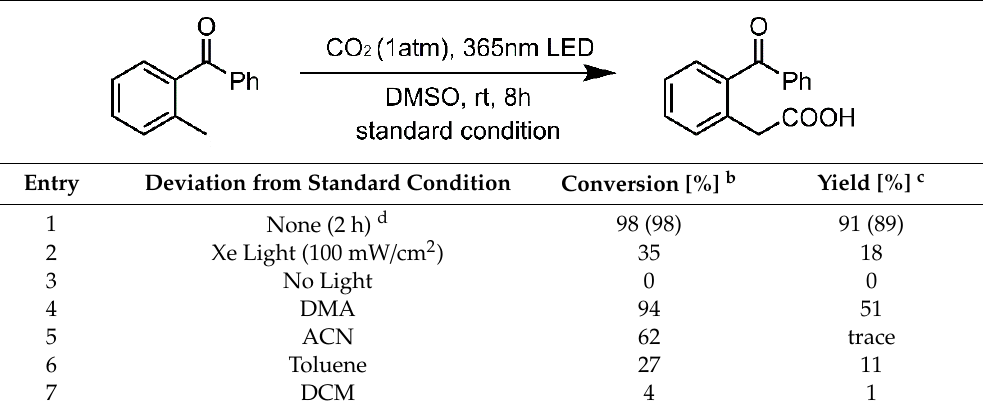
Table 1. Photo-carboxylation of o -methylbenzophenone with CO 2 a .